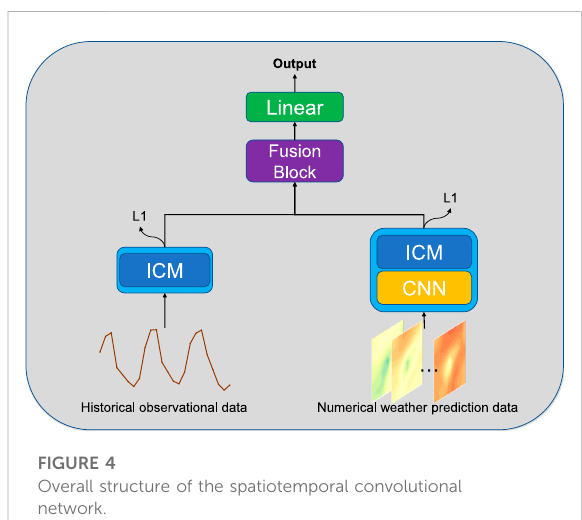
FIGURE 4 Overall structure of the spatiotemporal convolutional